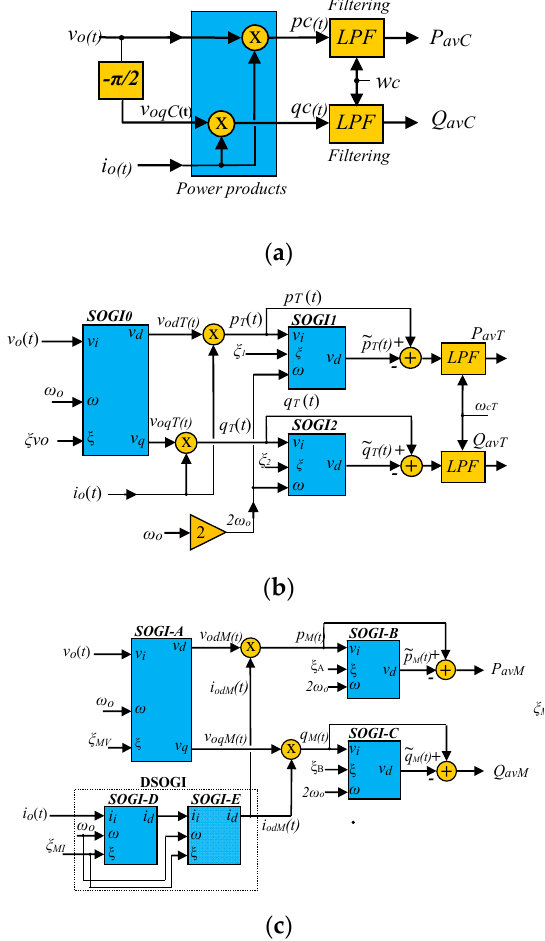
Figure 5. Three averaged active and reactive power calculation: ( a ) conventional droop P–Q calculation; ( b ) advanced P–Q calculation based on the schemes and algorithms reported in Reference [41]; and ( c ) P–Q calculation based on Reference [35].